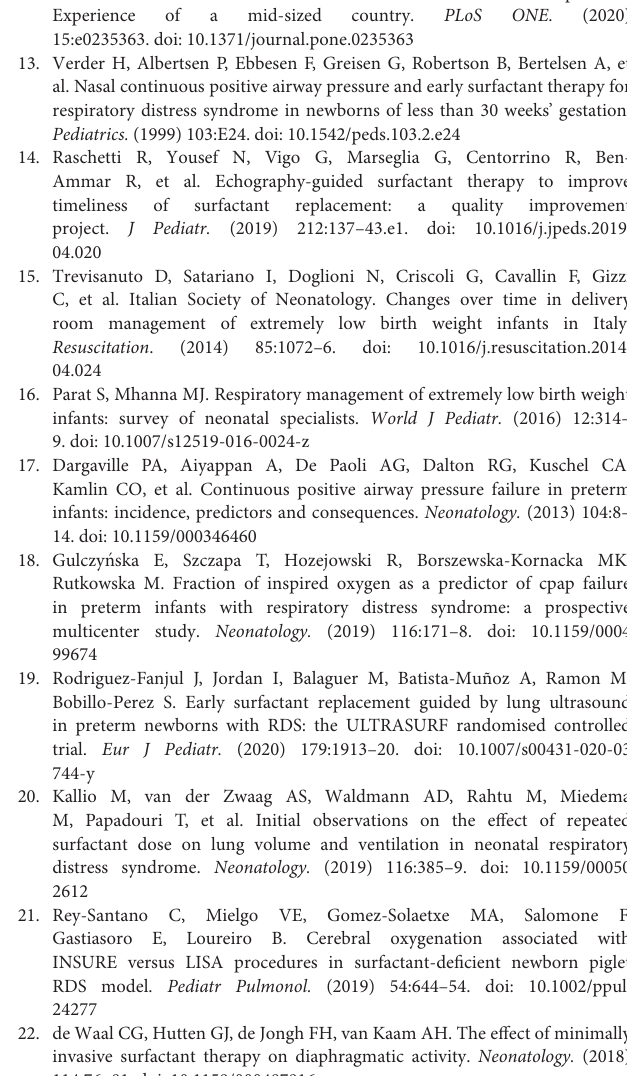
Supplementary Figure 1 | Time to surfactant plotted against FiO 2 before